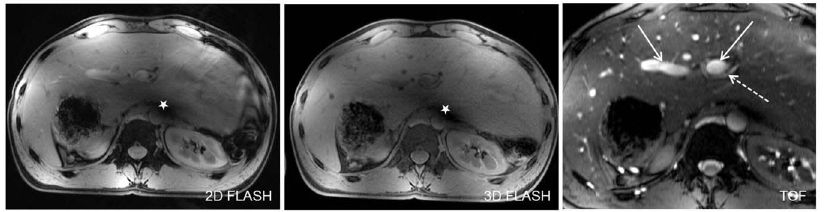
Figure 6. Figure 5 shows an anatomic variability of the upper abdomen in one healthy subject with a tall, centrally arranged liver and partially inverted situs, by means of mirrored location of spleen and stomach in the right upper abdomen. In this subject residual B 1 -artifacts strongly impaired the conspicuity of central liver vessels in 2D and 3D FLASH imaging (stars in Figure A). Yet, being the sequence to be least impaired, TOF imaging allowed for a high-quality assessment of portal vein (arrow) and the left hepatic artery (dashed arrow). Figure B shows high quality delineation of the splenic artery and several small branches at the splenic hilus in all three sequences (arrows).